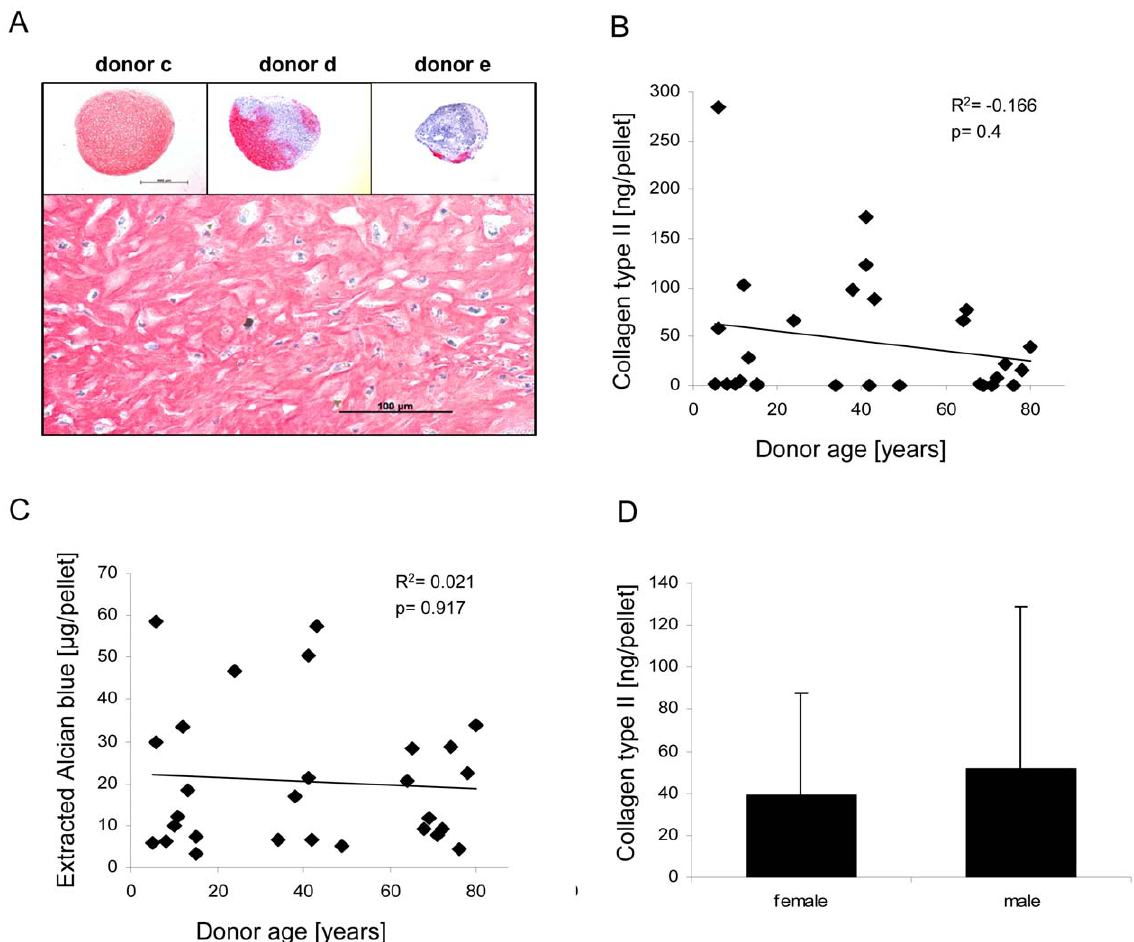
Figure 4. No correlation of chondrogenic differentiation with donor age and gender. 5 6 10 5 MSC were subjected to six weeks of chondrogenic induction in high density culture. From 6 parallel pellets per donor, 2 pellets were used for histological stainings, 2 pellets were processed for quantification of glycosaminoglycan deposition and 2 pellets for quantification of collagen type II deposition. (A) Immunohistochemical staining for collagen type II was used to confirm chondrogenic differentiation and the chondrocyte-like morphology of the cells. Staining varied from full to negative depending on the donor with similar variability in all age groups (A, inset). (B) The collagen type II content determined after pepsin digestion of pellets by ELISA revealed a weak trend of reduced chondrogenesis at older age. (C) Glycosaminoglycan deposition determined after staining the pellets with Alcian blue dye, washing and extracting the dye revealed a trend of reduced chondrogenesis at older age. (D) Collagen type II deposition in pellets from female and male donors showed no significant differences. Correlation was calculated by Spearman-Rho Test, group comparison by Mann-Whitney-U Test.